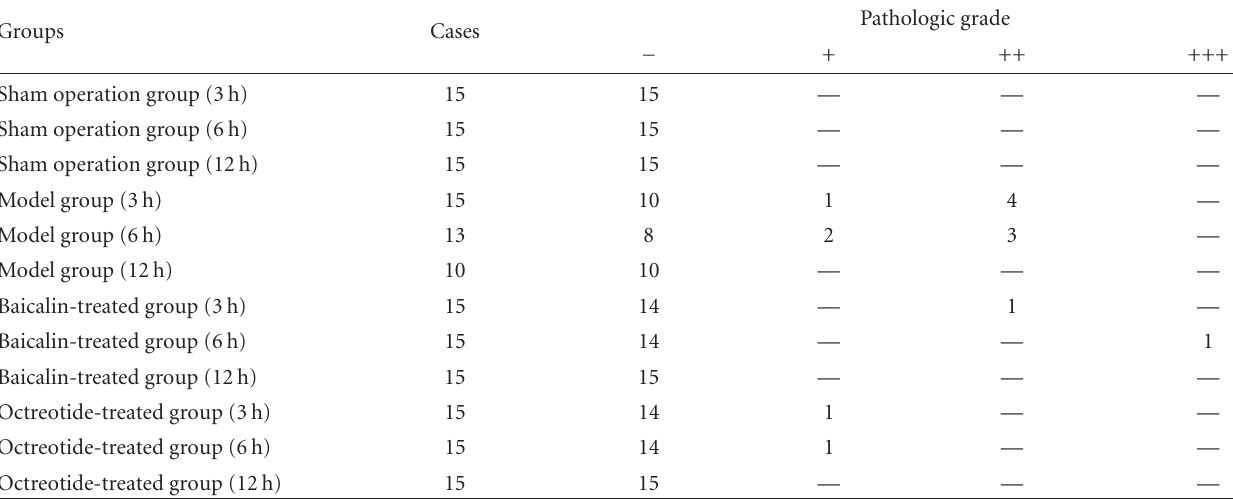
Table 5: Changes of Bax protein expression in all groups.